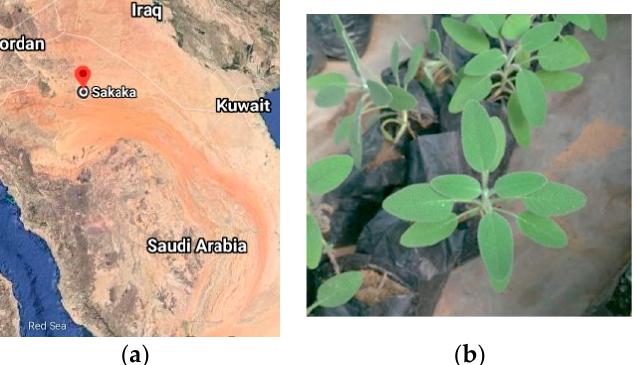
Figure 1. ( a ) Map of Kingdom of Saudi Arabia showing sampling site of the Sakaka, Aljouf region area and ( b ) S. officinalis L. leaves.